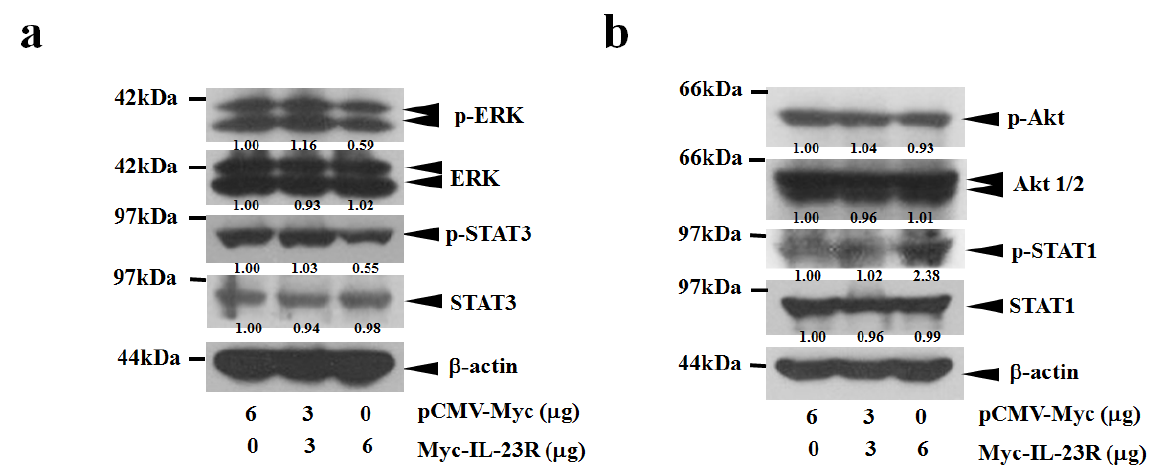
Figure 7. The intracellular signaling pathways are altered upon the overexpression of IL-23R in HeLa cells. ( a ) Western blot analysis was performed anti-phosphorylated extracellular regulated protein kinases (p-ERK), anti ERK, anti STAT3 and anti-phosphorylated STAT3 antibodies. β -actin gene expression was served as internal control; and ( b ) Western blot analysis was performed using using anti-phosphoryled Akt, anti Akt, anti-phosphorylated STAT1 and anti STAT1 antibodies. β -actin gene expression was served as internal control. In both ( a ) and ( b ), the relative intensity of the individual bands were calculated based on the expression of β -actin by using the Quantity One